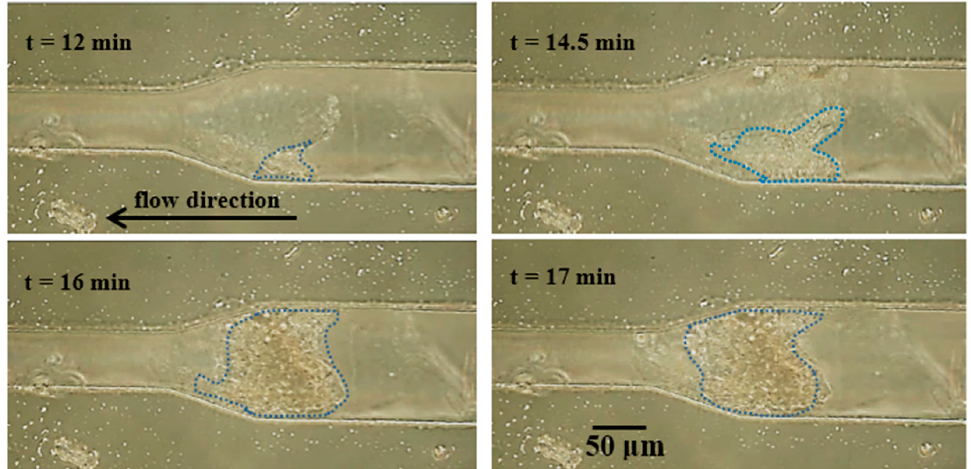
Figure 8. The clogging process of 5% alginate solution in the microchannel at the particle concentration of 1% and the constriction angle of 15°. The blue dotted line contours the agglomerated particles.